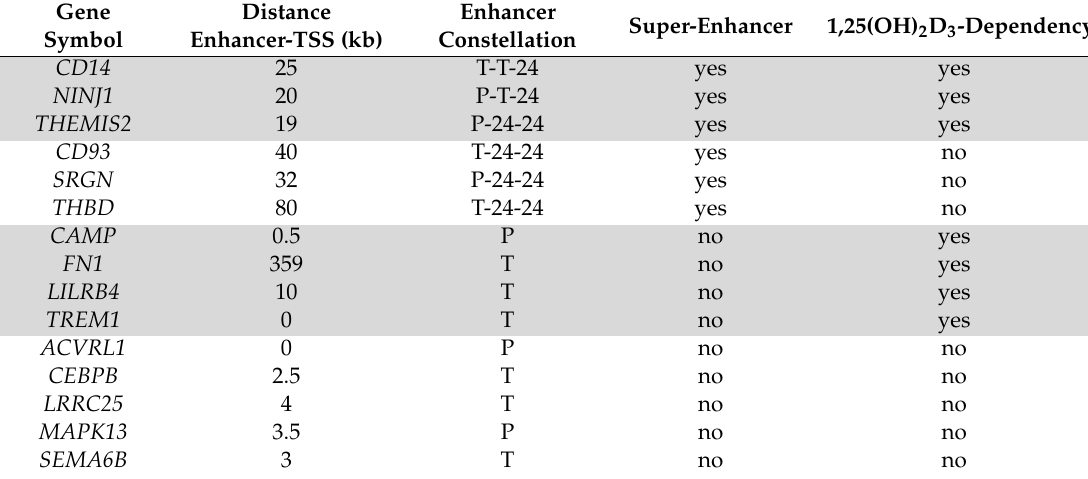
Table 1. Epigenomic classification of vitamin D target genes based on super-enhancers or single enhancers and their responsiveness to 1,25(OH) 2 D 3 . The types of vitamin D receptor (VDR) binding sites at enhancers are indicated as persistent (P), transient (T) and 24 h only (24) [28]. Gene Distance Enhancer Super-Enhancer 1,25(OH) 2 D 3 Symbol Enhancer-TSS (kb) Constellation